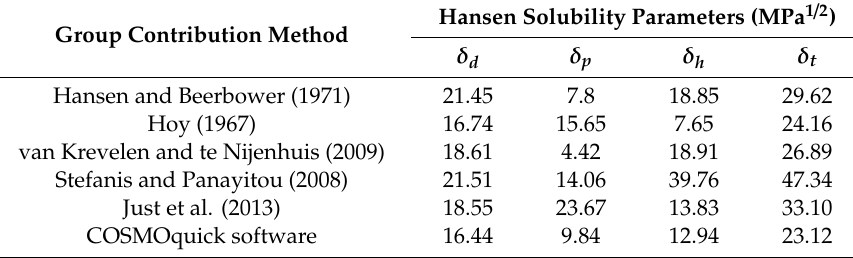
Table 2. Hansen solubility parameters for rosmarinic acid calculated by di ff erent group contribution